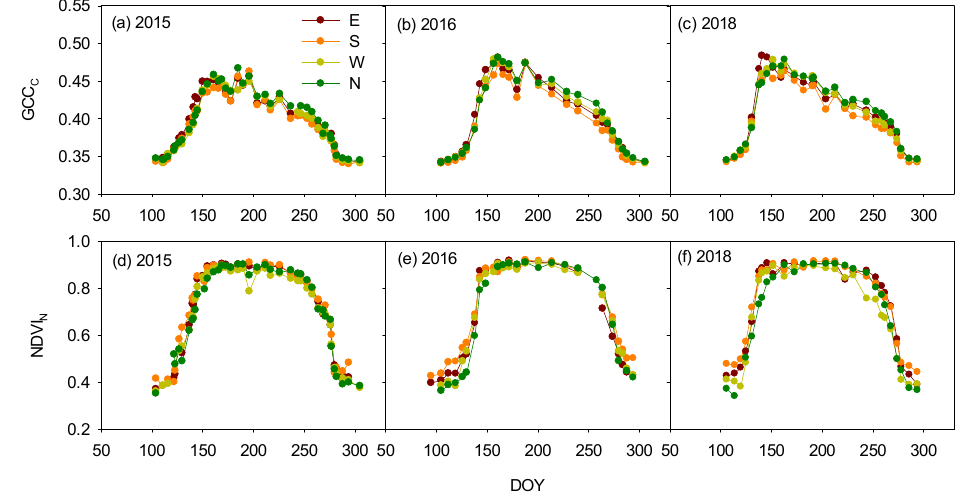
Figure 3. Seasonal variations in the green chromatic coordinate from camera (GCC C ) and narrowband normalized difference vegetation index from spectroradiometer (NDVI N ) at different azimuths with an inclination-angle of 30 ◦ in 2015 ( a , d ), 2016 ( b , e ), and 2018 ( c , f ). E, S, W, and N stand for east, south, west, and north direction, respectively.